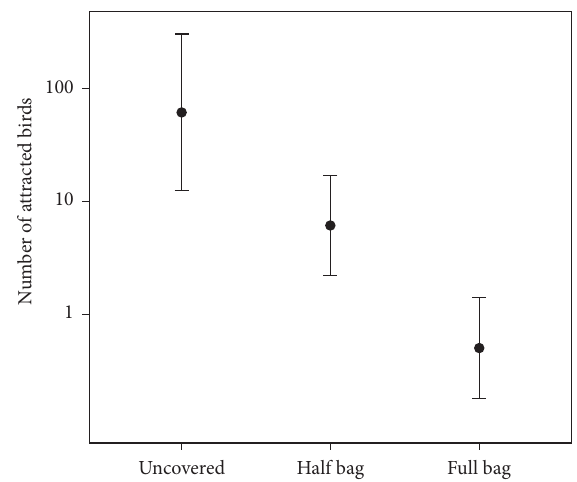
Figure 2: The number of birds (log) attracted to each treatment per dayforeachtreatmentgroup;“uncovered,”“halfbag,”and“fullbag” refer to an uncovered grape cluster, a cluster covered with a bag, half of which is clear and half of which is opaque white, and an opaque white bag, respectively. Error bars indicate 95% confidence intervals (GLMM; error distribution: Poisson).